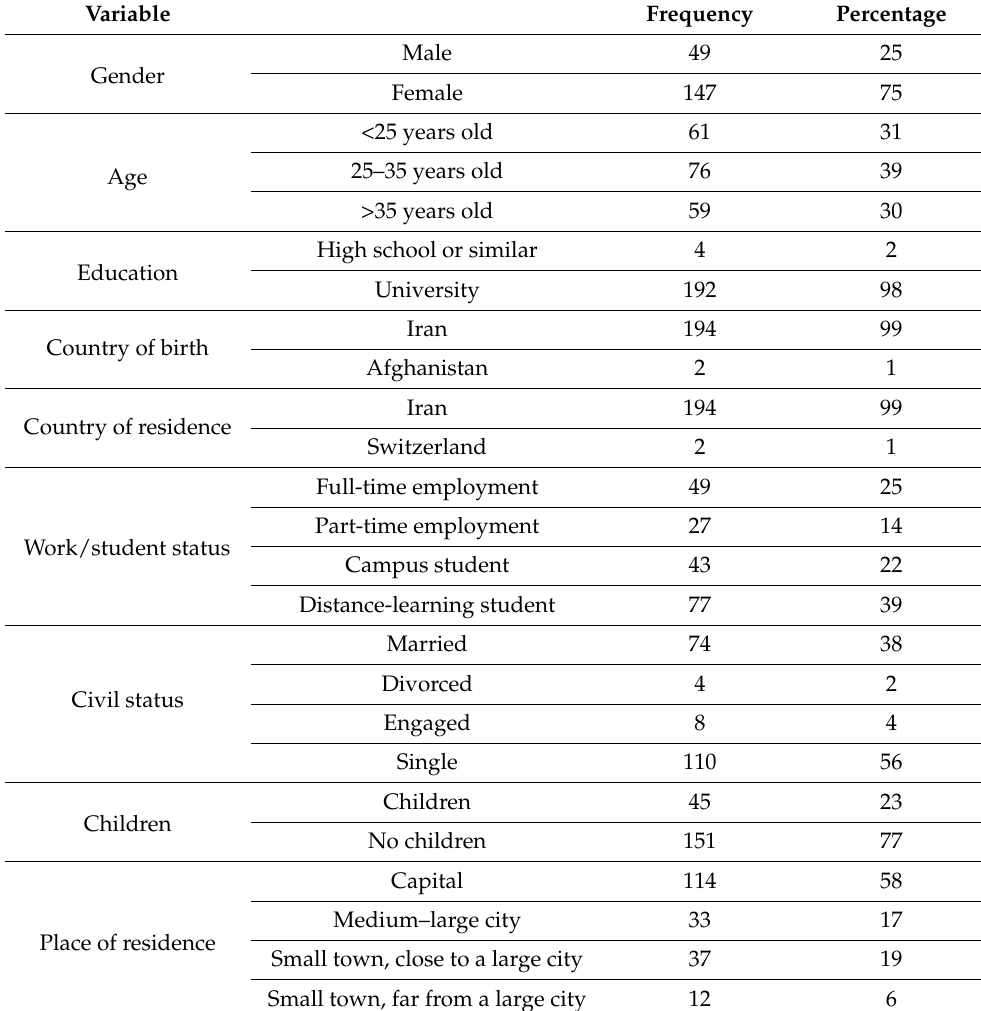
Table 1. Respondents’ demographic characteristics ( n =